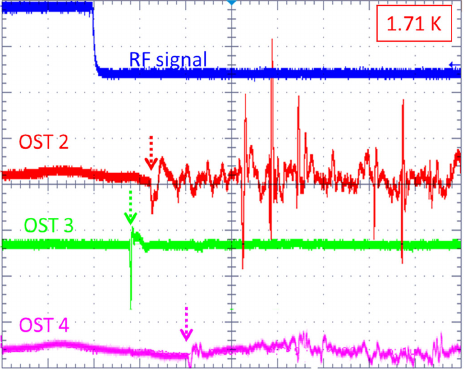
FIG. 4. Oscilloscope signals from OSTs during cavity quench. Vertical arrows show 2nd sound wave arrival on OST. between the two membrane plates. The two sides are charged with 120 V via a weakly coupled connection.